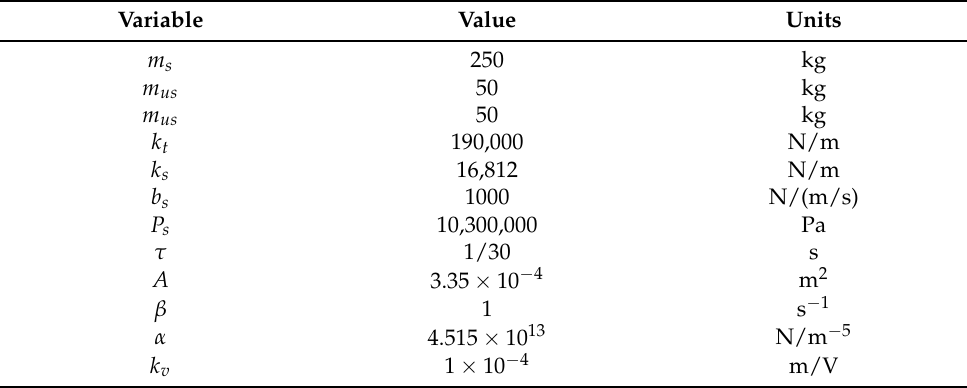
Table 1. Constant Values of the Active Suspension